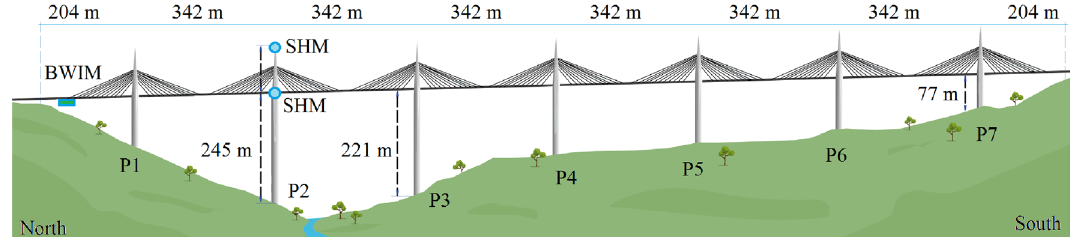
Fig. 4 Millau viaduct, position of SHM and BWIM